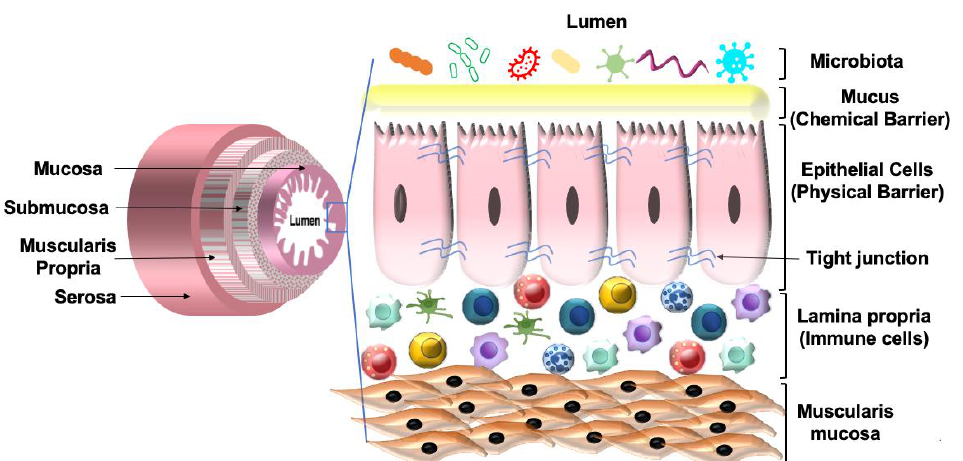
Figure 4. Schematic representation of the various layers of the GI tract. Mucus acts as a chemical barrier and separates the epithelial cells from the luminal contents while the epithelium and tight junction proteins provide a physical barrier to maintain gut integrity.